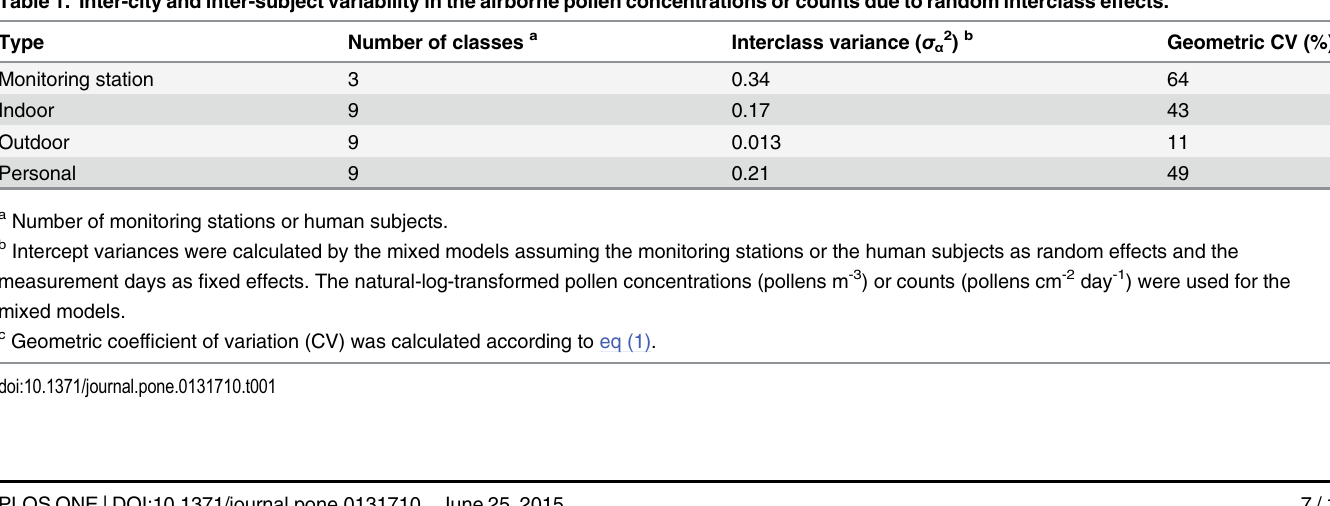
Table 1. Inter-city and inter-subject variability in the airborne pollen concentrations or counts due to random interclass effects. Type